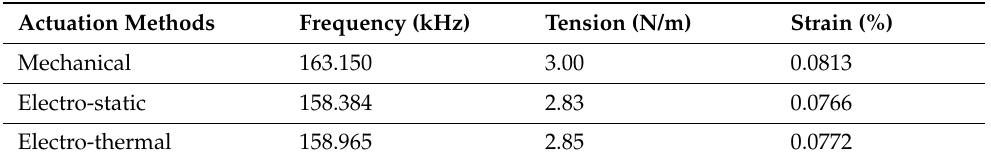
Table 2. Overall tension and strain in the graphene/PMMA membrane deducted from the measured resonant